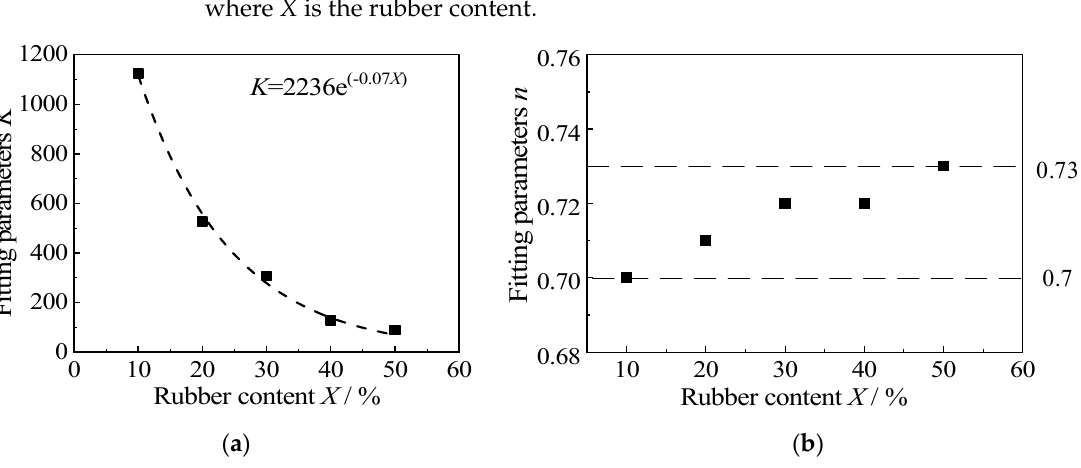
Figure 11. The relationship between the fitting parameters, K and n , and the cement content. ( a ) Fitting parameters K , ( b ) Fitting parameters n .